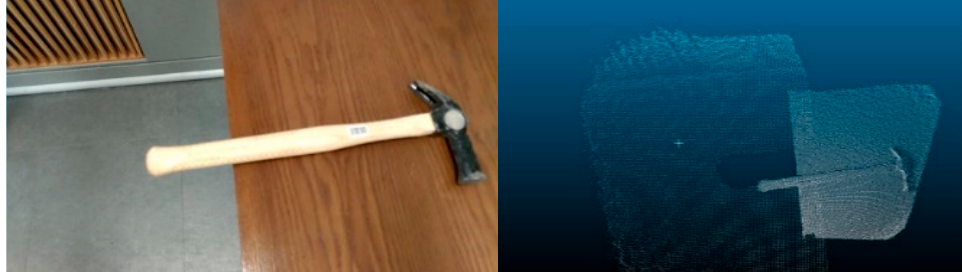
Figure 16. Object RGB image data and collected 3D point cloud data. Table 2. Examples of 3D point cloud data and corresponding calculated depth